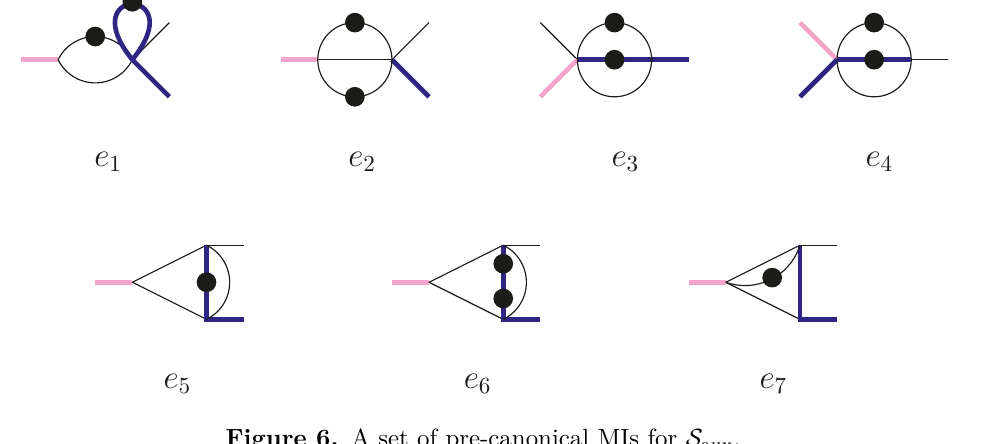
Figure 6. A set of pre-canonical MIs for S aux